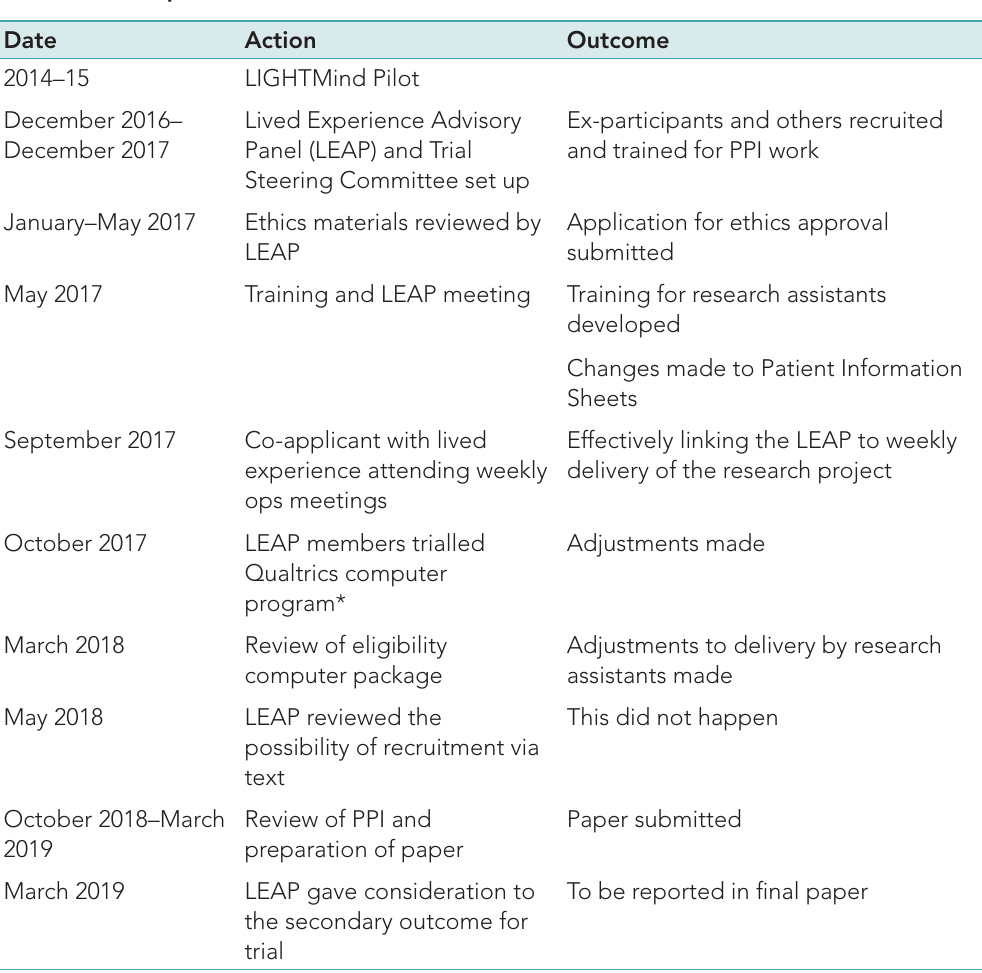
Table 1: Description of PPI